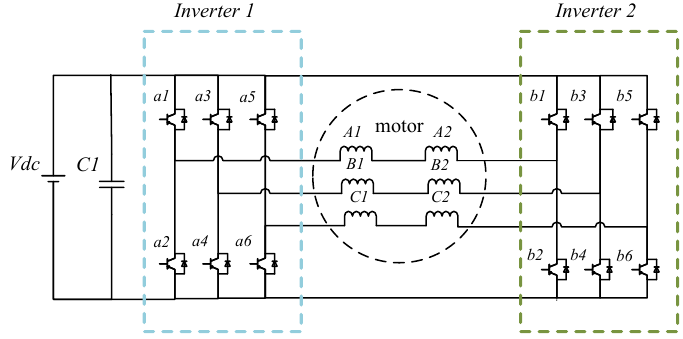
Figure 1. Structure of open winding techniques.